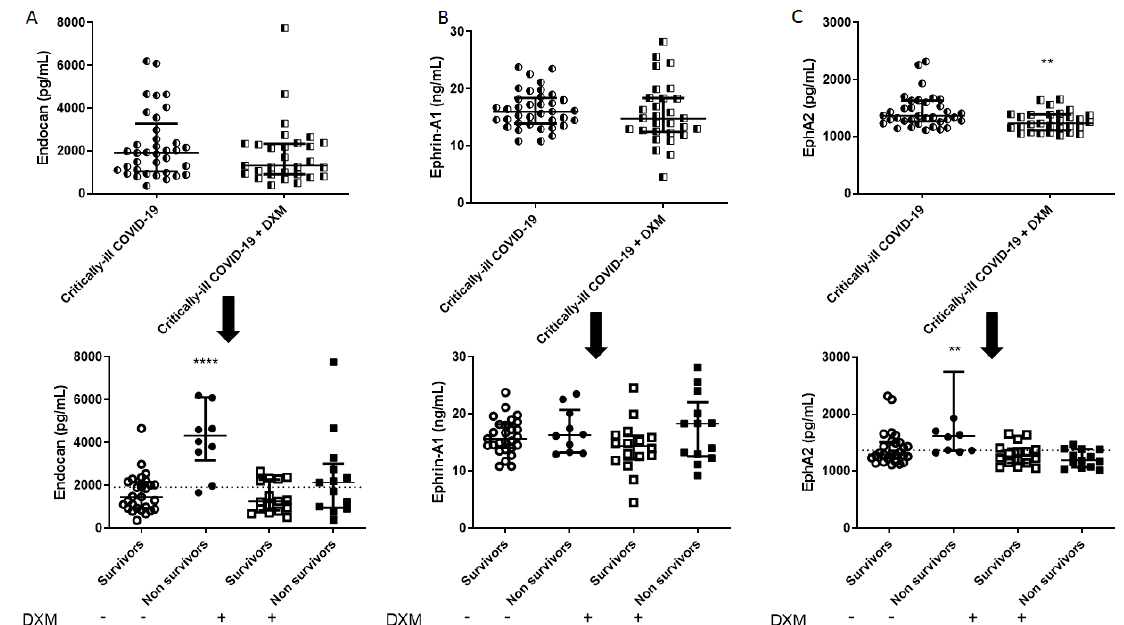
Figure 4. Intensive care unit (ICU) admission levels of endothelial dysfunction biomarkers in COVID-19 patients. ( A ) Endocan, ( B ) Ephrin-A1, and ( C ) EphA2 were measured in 37 dexamethasone-free and 29 dexamethasone-treated (first dose—6 mg) critically ill patients upon ICU admission (within 24 h) (upper panels). The two patient groups were subsequently categorized as survivors and non-survivors (lower panels). Two-group comparisons were performed with the non-parametric Mann–Whitney test, ** p < 0.01, **** p < 0.0001. Data are presented as scatter plots, indicating the median value and 25 to 75 centiles. Dashed lines, median values of the dexamethasone-free group. DXM = Dexamethasone; EphA2 = Ephrin receptor A2. ROC curves were generated to determine the prognostic accuracy of sVCAM-1, su- PAR, presepsin, or their combination, in predicting ICU mortality in the dexamethasone- free group; the areas under the curve (AUC) were: 0.87 (95% CI = 0.75–0.99, p < 0.001), 0.95 (0.89–1.01, p < 0.0001), 0.83 (0.69–0.98, p < 0.01), and 0.95 (0.88–1.01, p < 0.0001), respectively (Figure 5A). According to the ROC analysis, the optimal cut-off points, and respective sensitivities and specificities for the biomarkers and their combination are given in Figure 5C. The prognostic accuracy of sVCAM-1, suPAR, presepsin, and their combination, fol- lowing dexamethasone administration, is shown in Figure 5B; the AUCs were: 0.73 (95% CI = 0.53–0.93, p < 0.05), 0.85 (0.70–0.99, p < 0.01), 0.84 (0.68–1.00, p < 0.01), and 0.95 (0.88– 1.02, p < 0.0001), respectively (Figure 5B). The optimal cut-off points and respective sensi- tivities and specificities for the biomarkers and their combination are given in Figure 5D.